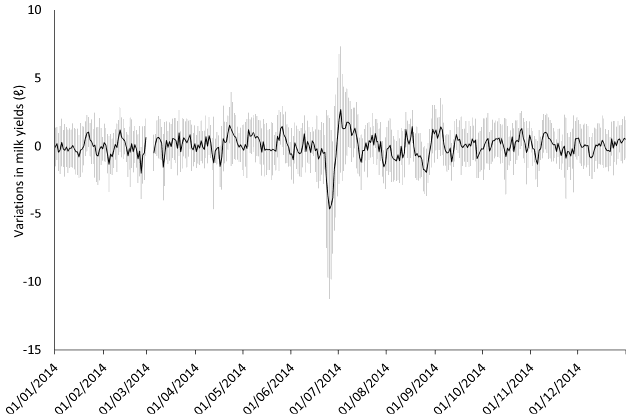
Figure 4. The variations of milk yields in the total observation period (Mean ± Standard deviation). The blank area indicates no observation.